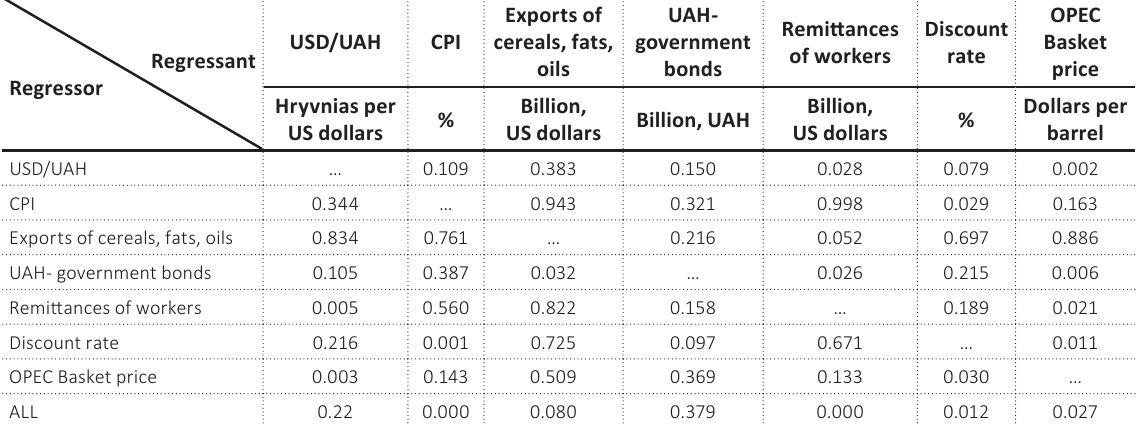
Table 5. Granger causality test results for VAR (2) model